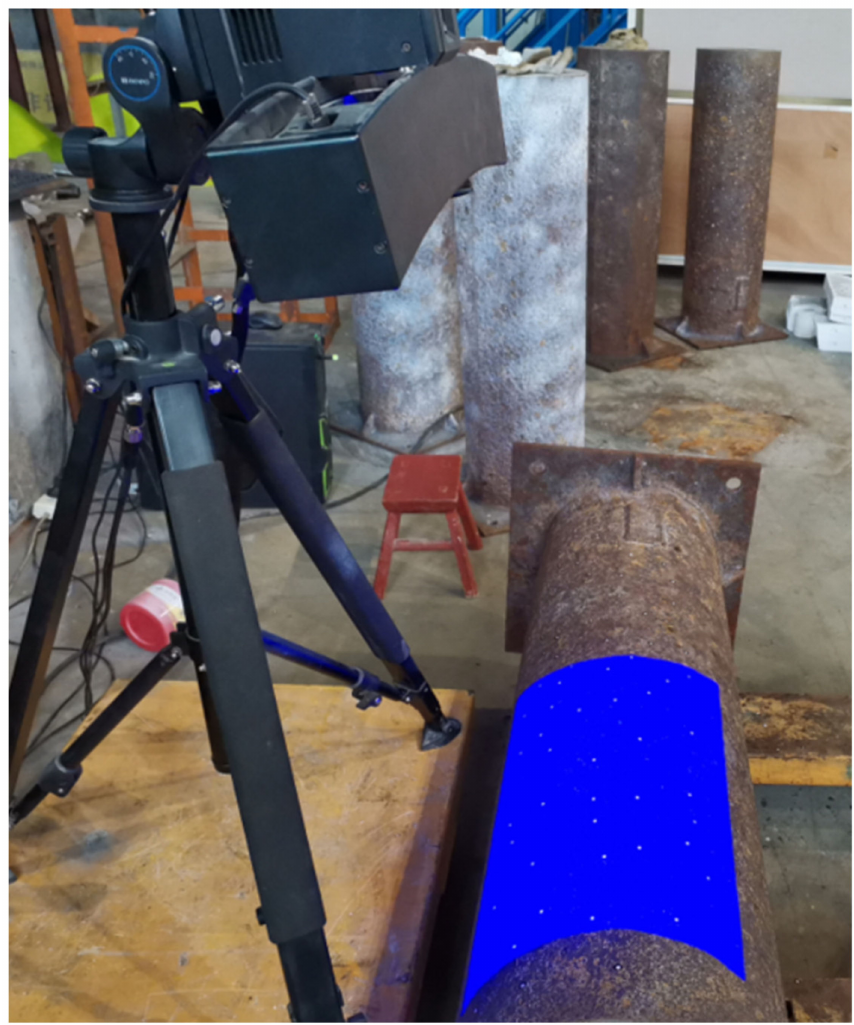
Figure 3. Scanning of corroded CFST